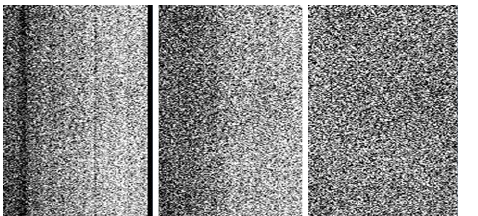
Figure 6. (a) Raw Antarctic image collected on orbit, high (HF) and low (LF) frequency vertical streaks are visible (b) Raw image radiometrically corrected with the pre-launch calibration